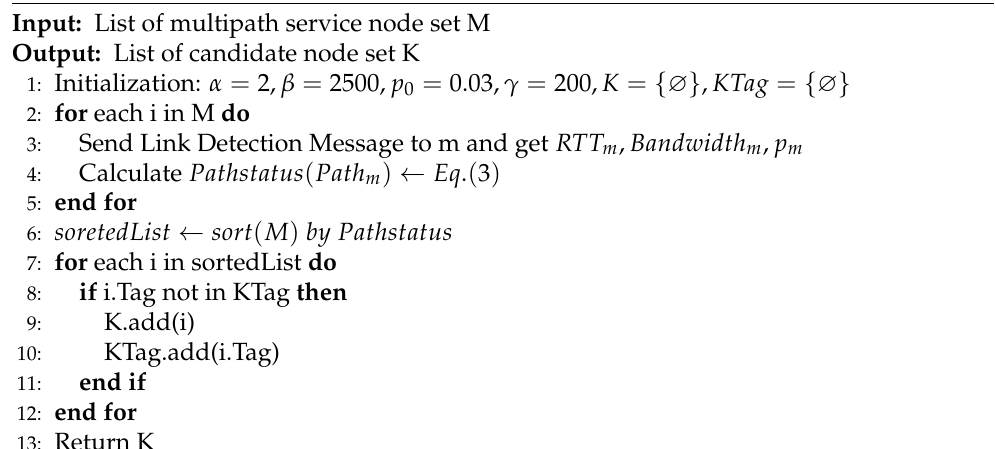
Algorithm 1 Multipath Service Node Selection